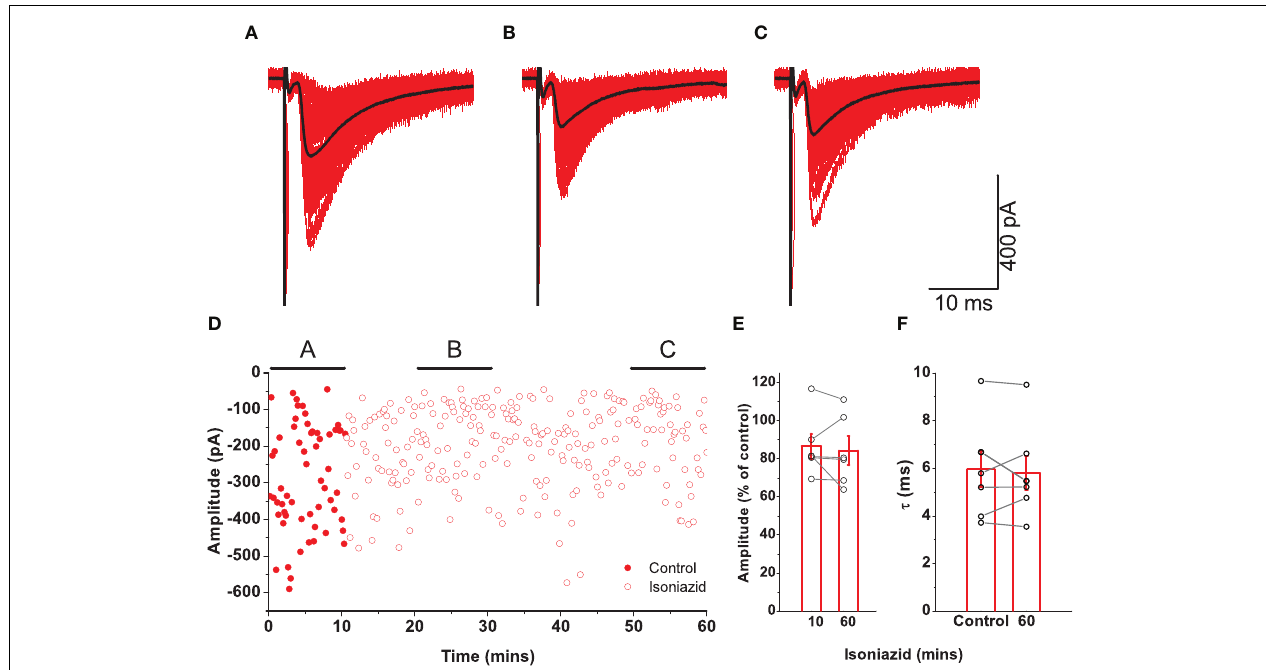
in amplitude, illustrating the time periods corresponding to (A–C) , and shows a modest but rapid reduction in current.The group data for all motoneurons shows that the attenuation of evoked IPSCs [graph (E) ] after 1h was no greater than that observed after ∼ 10min, and that isoniazid superfusion had no systematic effect on the decay time constant [graph (F)